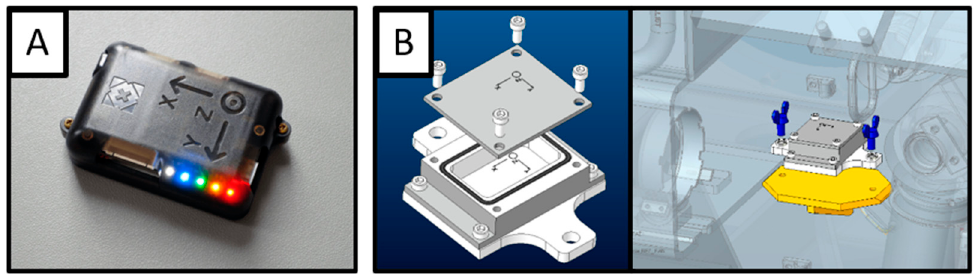
Figure 2. Data acquisition layer—main components: ( A ) NGIMU sensor unit; ( B ) Steel housing of the device and the method of installation on the